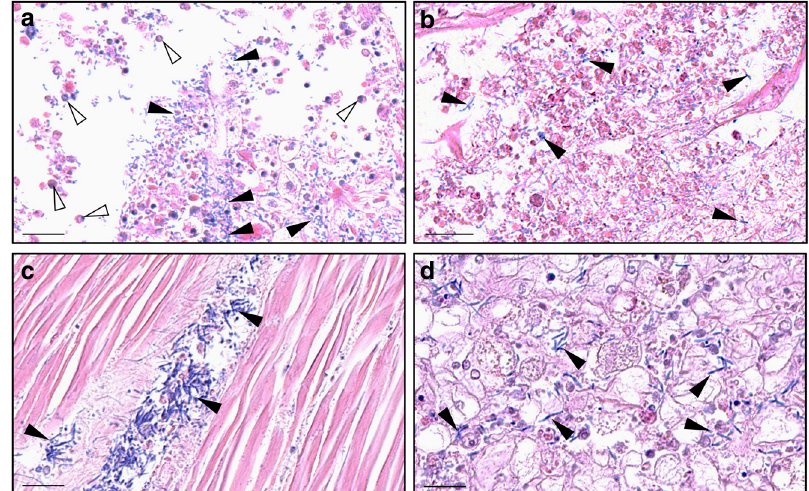
Fig. 4 Accumulation of bacteria in tissues of the susceptible S F11 oysters. Giemsa staining was performed on paraf fi n wax-embedded tissue histological sections of S F11 oysters sampled at different time points to visualize tissue colonization by bacteria. Oyster tissues and cells were coloured in shades of pink to purple, and most bacteria appeared in deep blue (scale bars corresponds to 20 µ M). a At 54 h after the beginning of the ‘ natural ’ experimental infection, bacteria accumulated in the gills of the S F11 oysters ( fi lled arrowheads). Rounded cells reminiscent of haemocytes were found in both gill tissues and outside tissues in the vicinity of the bacteria (open arrowheads). At 78 h, gill tissues appeared massively degraded, and bacteria were found in most tissues of the S F11 oysters, e.g., in b gills, c adductor muscle and d interstitial tissues near the digestive tract. No bacteria or tissue damage were observed on sections of S F11 or R F21 either at the beginning of the experimental infection or at any time points for the R F21 oyster sections (Supplementary Fig. 8)